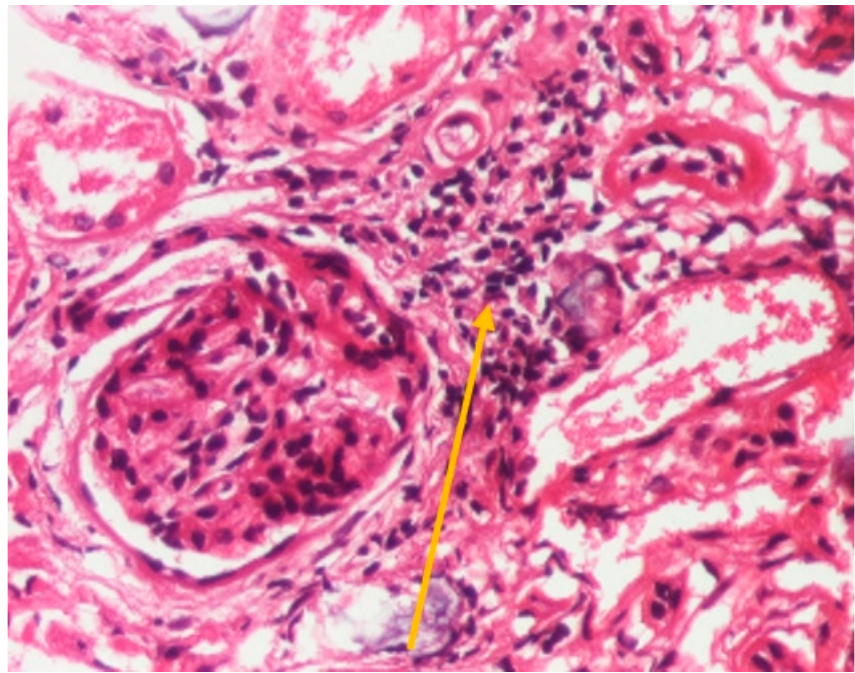
Figure 7. Hematoxylin-eosin staining × 200; renal tissue showing interstitial inflammation (yellow arrow) (personal collection, St. Mary Emergency Children’s Hospital, Iasi).